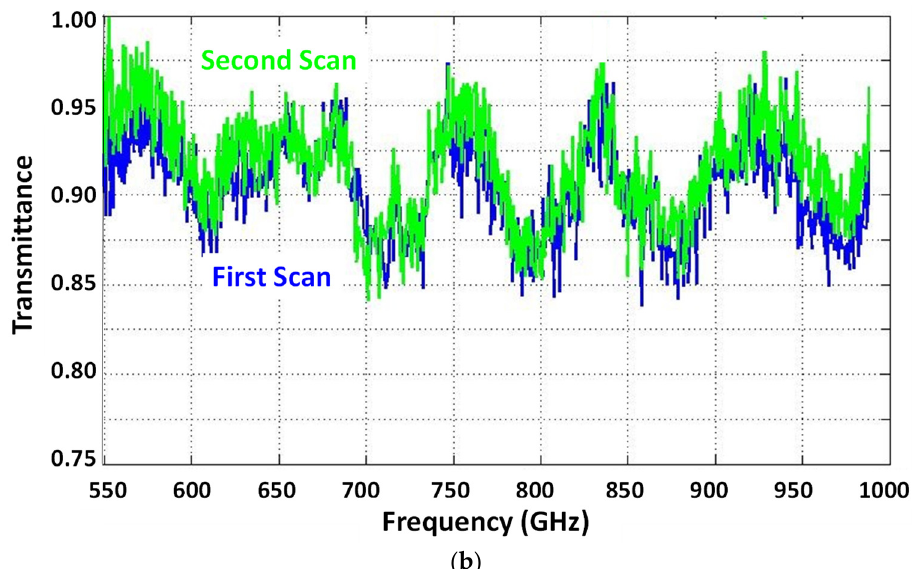
Figure 6. ( a ) Transmittance spectrum for the λ -DNA sample between 500 and 1000 GHz. ( b ) Repeat measurement of same λ -DNA sample to check for reproducibility. Table 2. Spectroscopic and optical parameters for three prominent absorption signatures in 1-kbp DNA